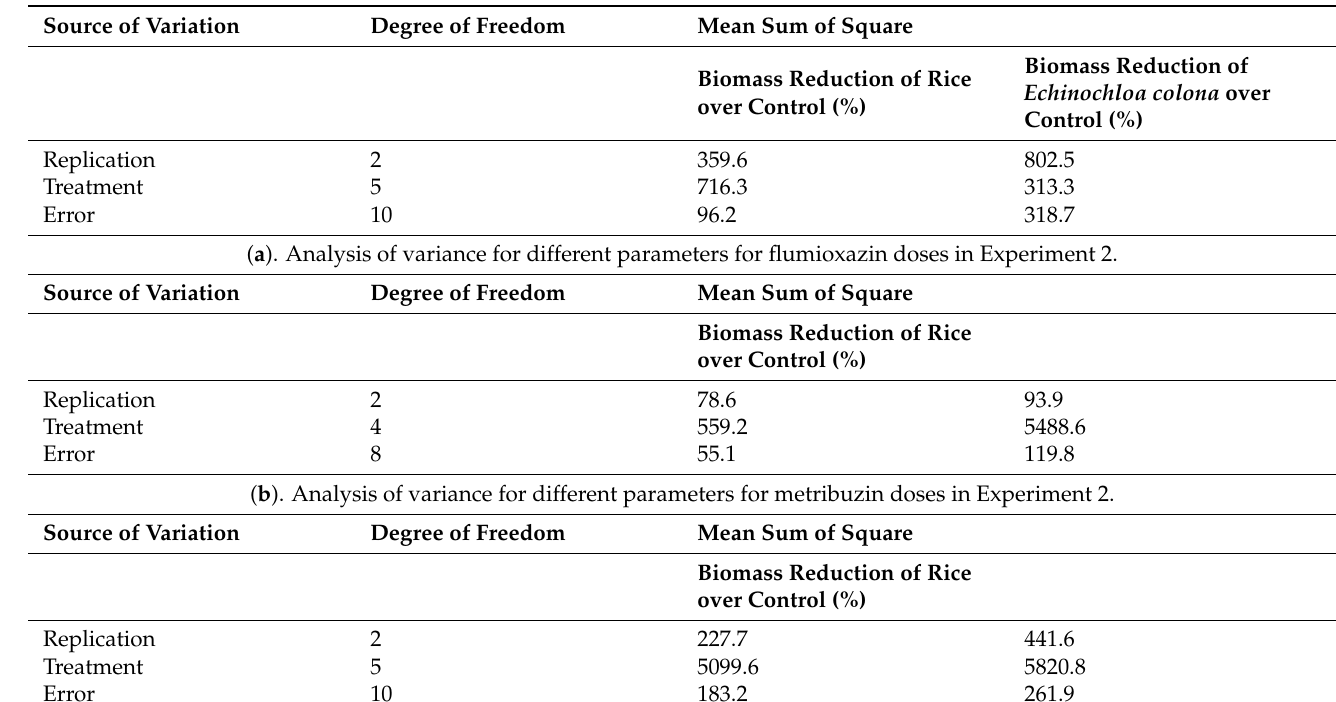
Table A3. Analysis of variance for different parameters for atrazine doses in Experiment